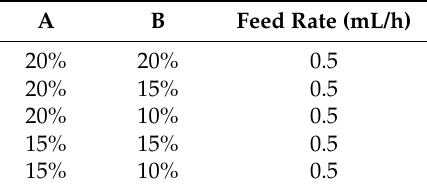
Table 6. The concentrations of the nylon 6 solutions used for parallel electrospinning.